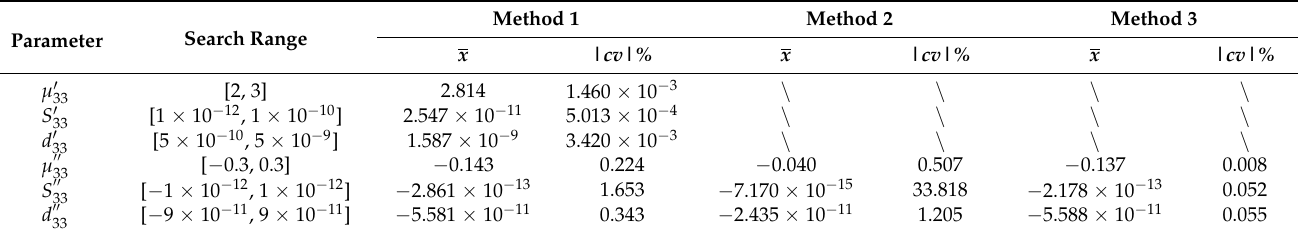
Table 7. Extraction results and the coefficients of variation for six parameters.